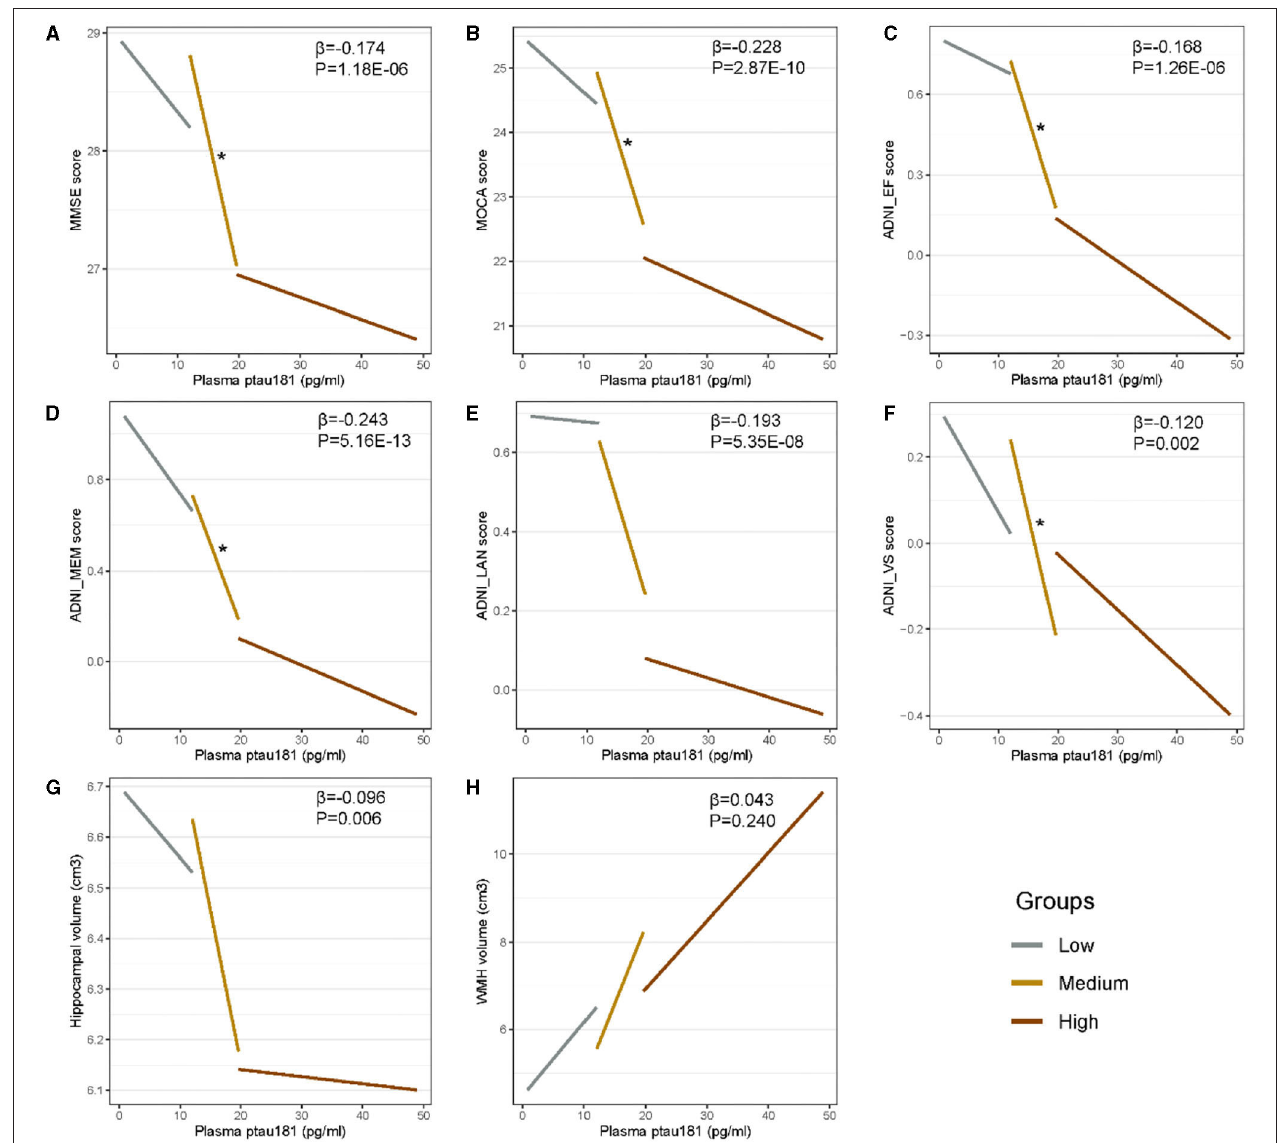
FIGURE 3 | (A–H) Cross-sectional associations of plasma p-tau181 with cognition and neuroimaging biomarkers. Plasma p-tau181 is categorized into three 33% terciles: low < 12.03 pg/ml, medium 12.04–19.63 pg/ml, and high > 19.65 pg/ml. Significant correlations ( p < 0.05) are indicated by “*” in different levels of plasma